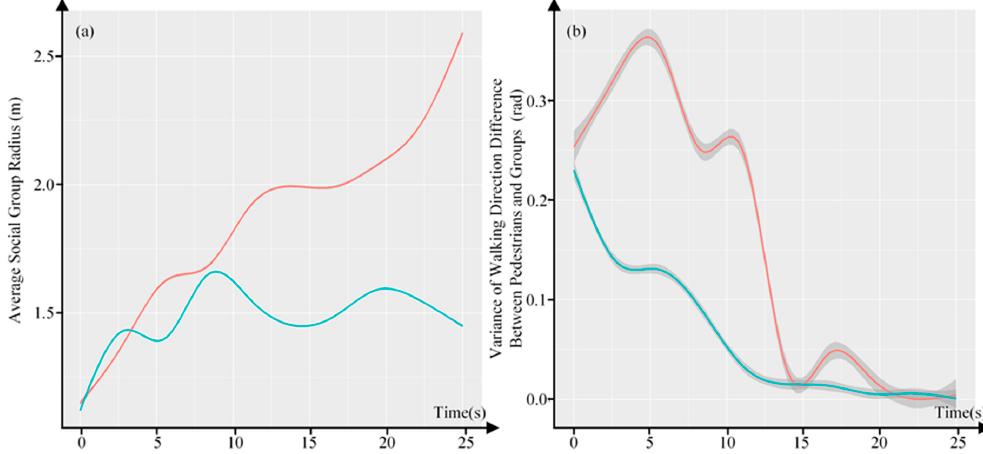
Figure 12. Quantitative comparisons between the extended social force model (Red) and the social group force model (SGFM (Blue). ( a ) The change of average social group radius. ( b ) The change of variance of walking direction difference between pedestrians and groups.